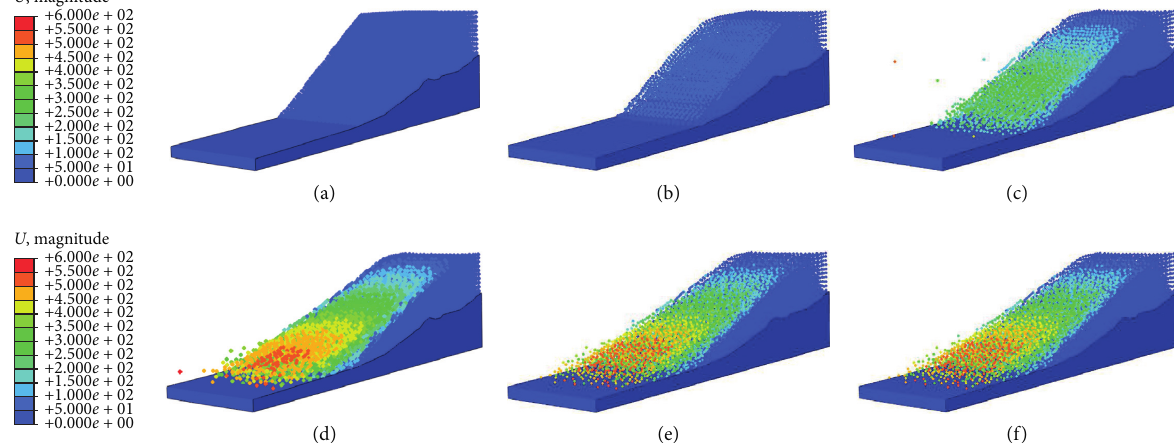
Figure 17: The displacement (U magnitude) and shapes of the landslides at different times (number of particles:11700). (a) t � 0 s. (b) t � 8s. (c) t � 17 s. (d) t � 30s. (e) t � 40 s. (f) t � 100s.